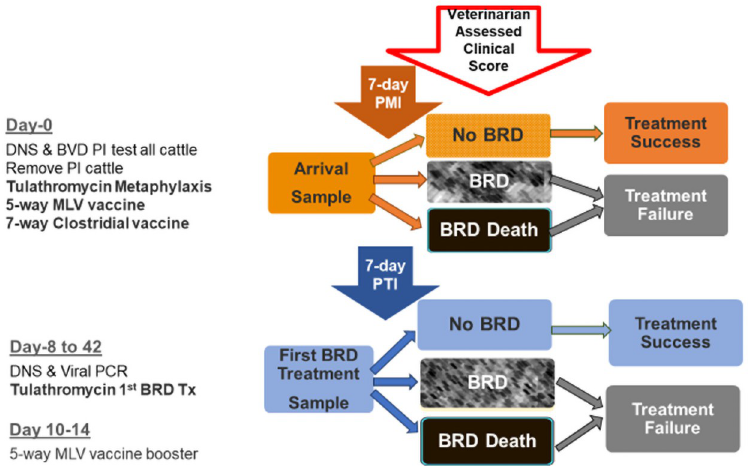
Fig 1. Study timeline. Nasopharyngeal swab, tulathromycin susceptibility, M . haemolytica , P . multocida , bovine respiratory disease, bacterial culture, viral PCR.